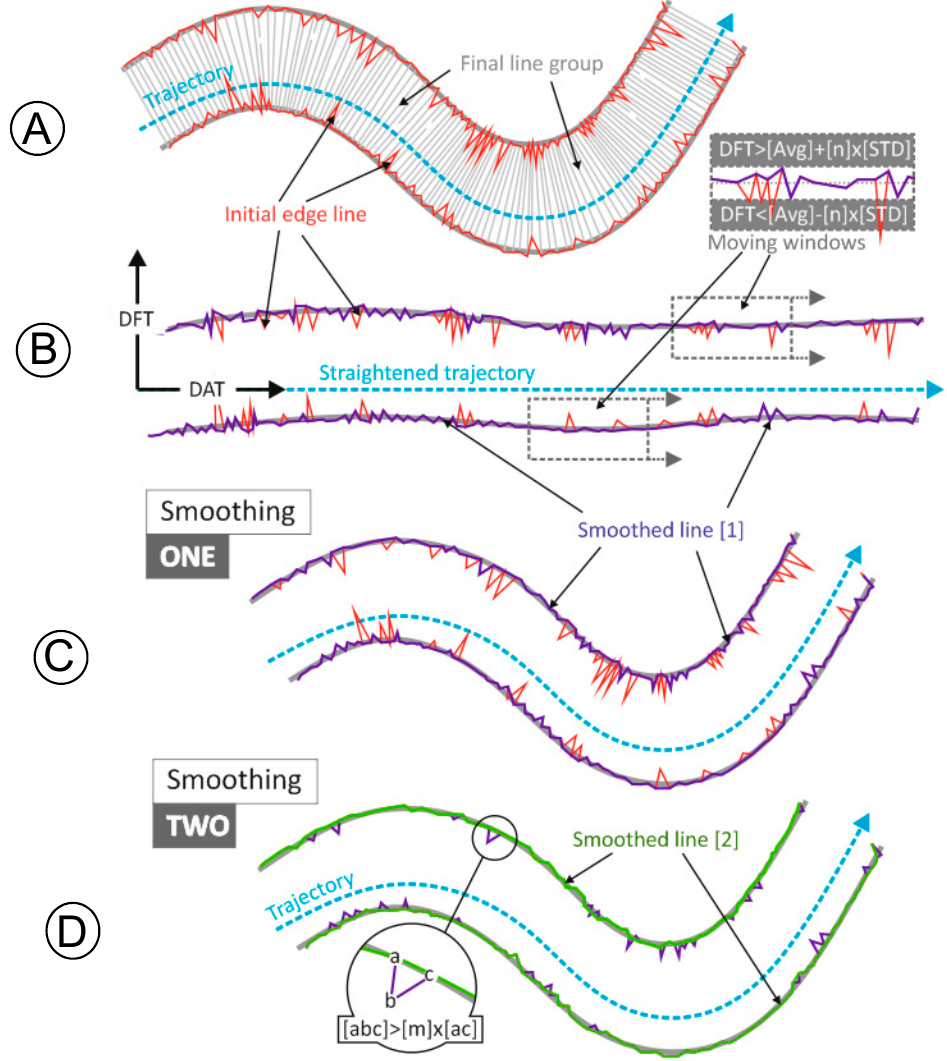
Figure 6. Example of line road edge polyline smoothing on a hypothetical road section. ( A ) final line group and initial edge polyline; ( B ) straightened trajectory, initial edge line transformed into (DFT, DAT) coordinates, and moving window; ( C ) result of the Smoothing one; ( D ) result of the Smoothing two.